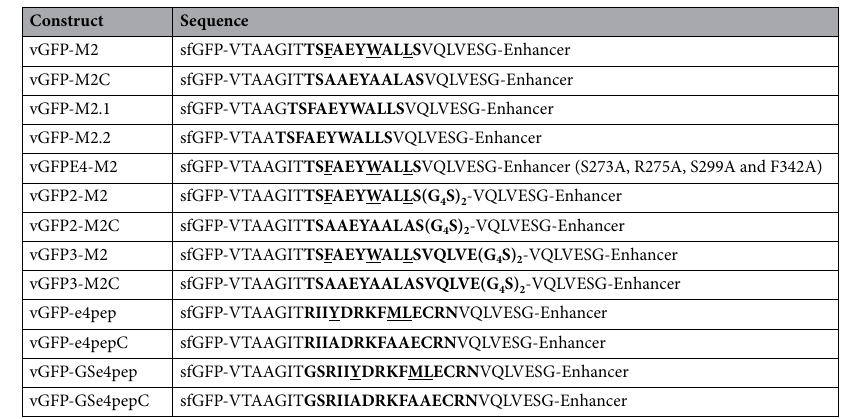
Table 1. vGFP peptide-displaying constructs used in this study. Amino acids in bold depict peptide sequences grafted in linker region between sfGFP and the Enhancer components of vGFP. Underlined residues in